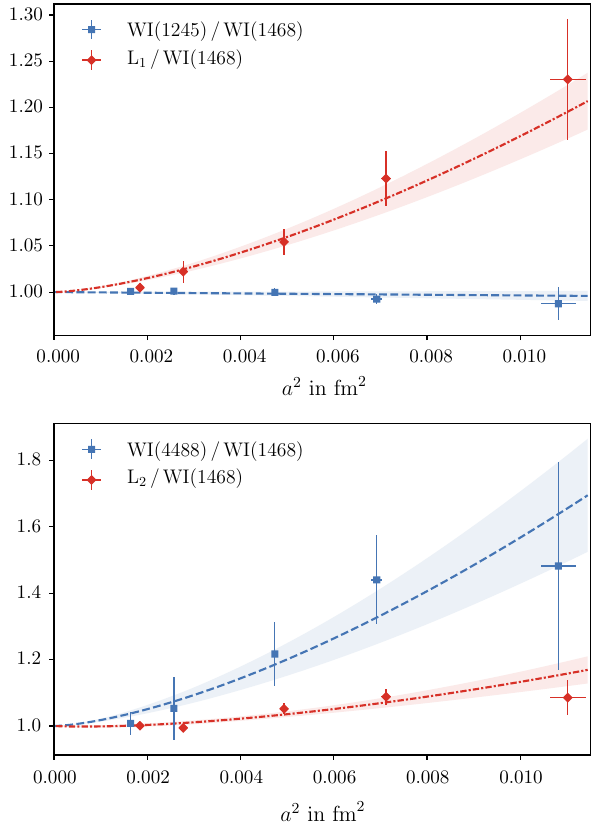
Fig. 5 Lattice spacing dependence of the ratio of different Z S / Z P determinations to Z S / Z P from WI(1468). The top panel depicts results from Ward identities which involve quark-connected diagrams only, while the bottom panel shows results from Ward identities which also involve quark-disconnected diagrams